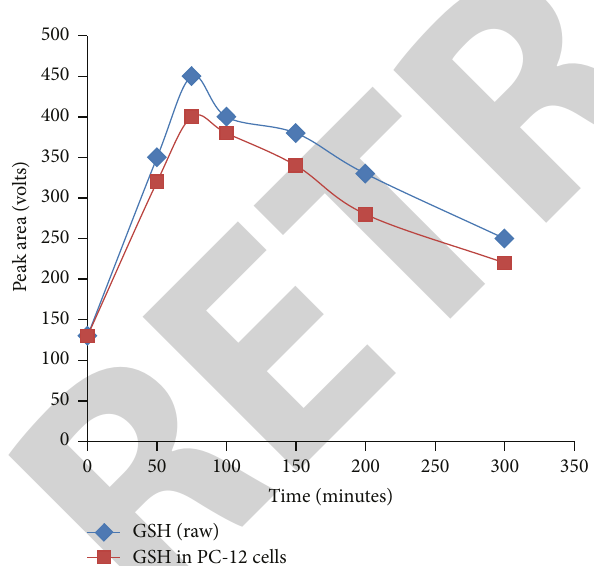
Figure 5: Stability studies of glutathione over a time period of